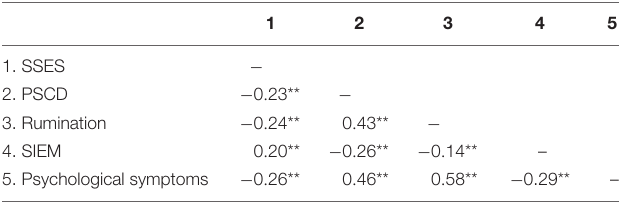
TABLE 2 | Correlations between key